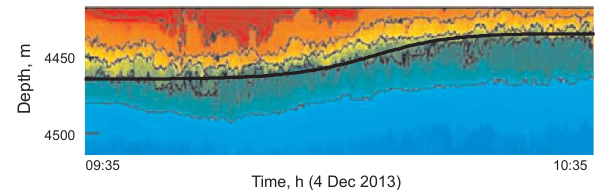
Figure 3. Internal front in abyssal stratified flow.